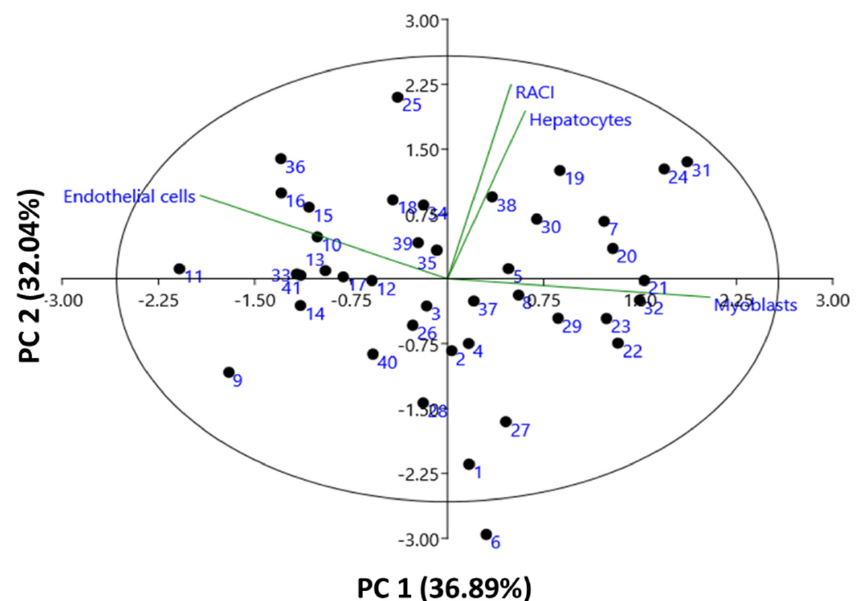
Figure 2. 2D scatter diagram of principal component analysis (PCA) of whole wheat extracts (WWE) based on antioxidant and cytoprotective